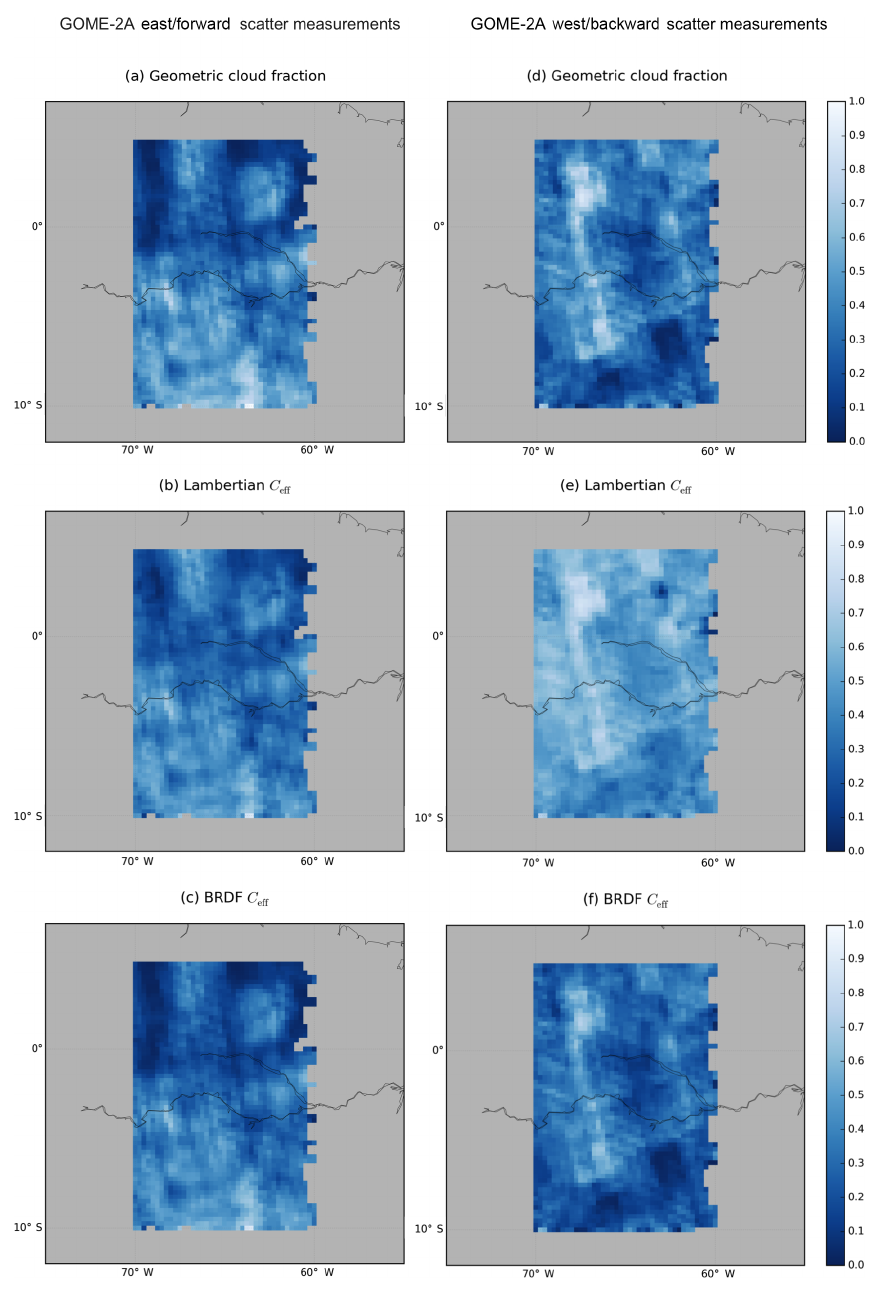
Figure 8. Geometric cloud fraction distributions for (a) east and (d) west GOME-2A measurements. (b, e) Lambertian and (c, f) BRDF cloud fraction simulations for east (a–c) and west (d–f) GOME-2A measurements. Plots show averaged cloud fractions in a 0 . 25 ◦ × 0 . 25 ◦ grid over Amazonia (lat: 5 ◦ N–10 ◦ S, long: 60–70 ◦ W) for March